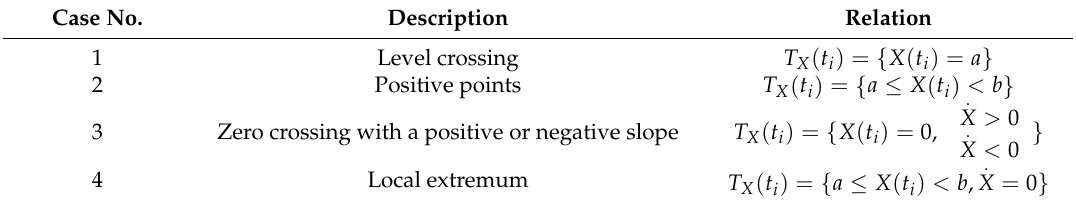
Figure 2. Basic concept of the special averaging in RD technique. Table 1. Triggering levels recommended by different researchers